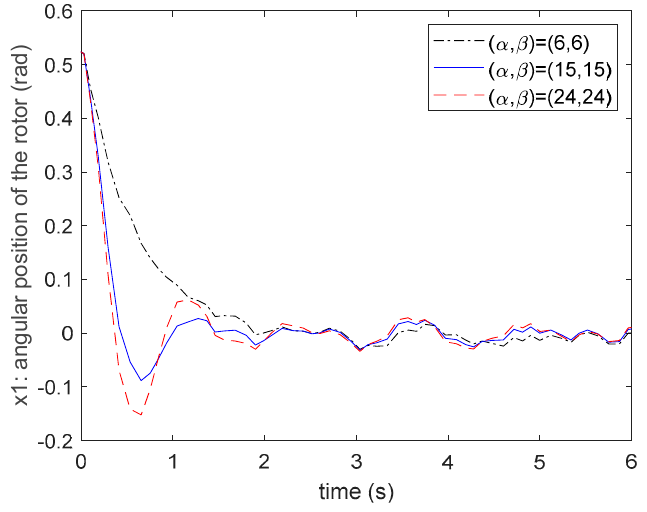
Figure 9. The comparisons of state ( )